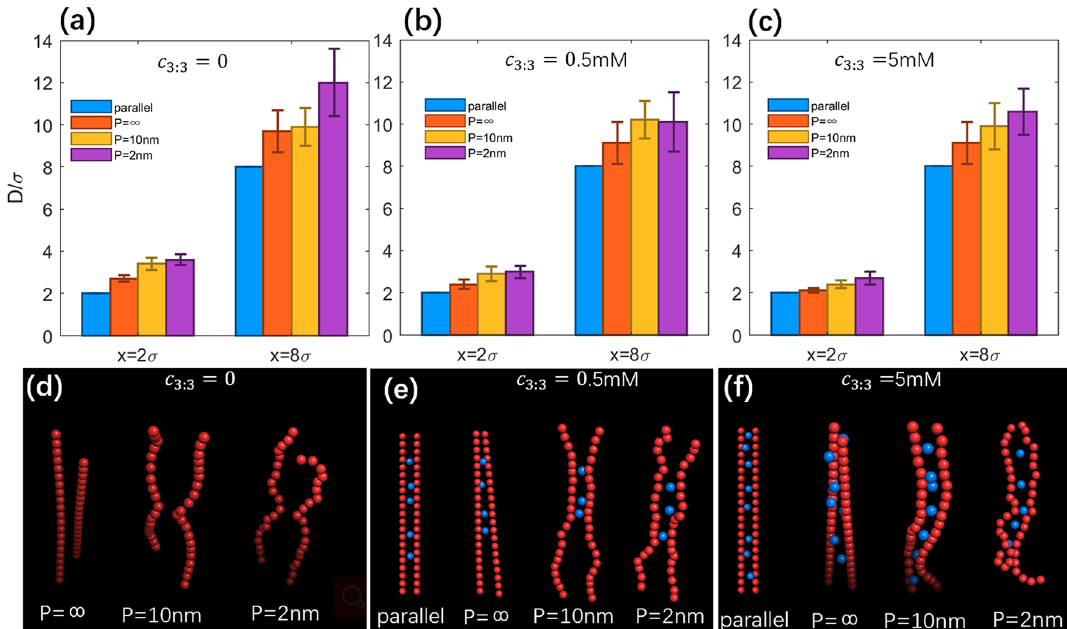
Figure 3. ( a – c ) Effective separation D between two PEs with different intrinsic persistene lengths P at the typical separations ( x = 2σ and x ref = 8σ): c 3:3 = 0 ( a ), c 3:3 = 0.5 mM ( b ) and c 3:3 = 5 mM ( c ). Errorbars represent the corresponding standard deviation Δ D . ( d – f ) Typical conformations of PEs with different persistene lengths P for different salt conditions: c 3:3 = 0 ( d ), c 3:3 = 0.5 mM ( e ) and c 3:3 = 5 mM ( f ). Red spheres represent monomers of PEs and blue spheres represent the bridging trivalent